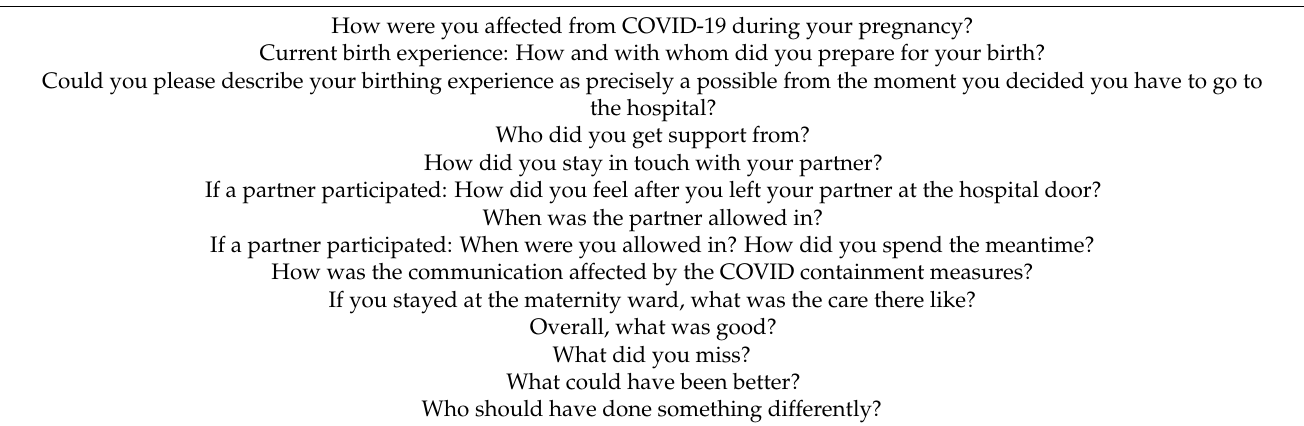
Table 3. Interview guide with participating mothers and